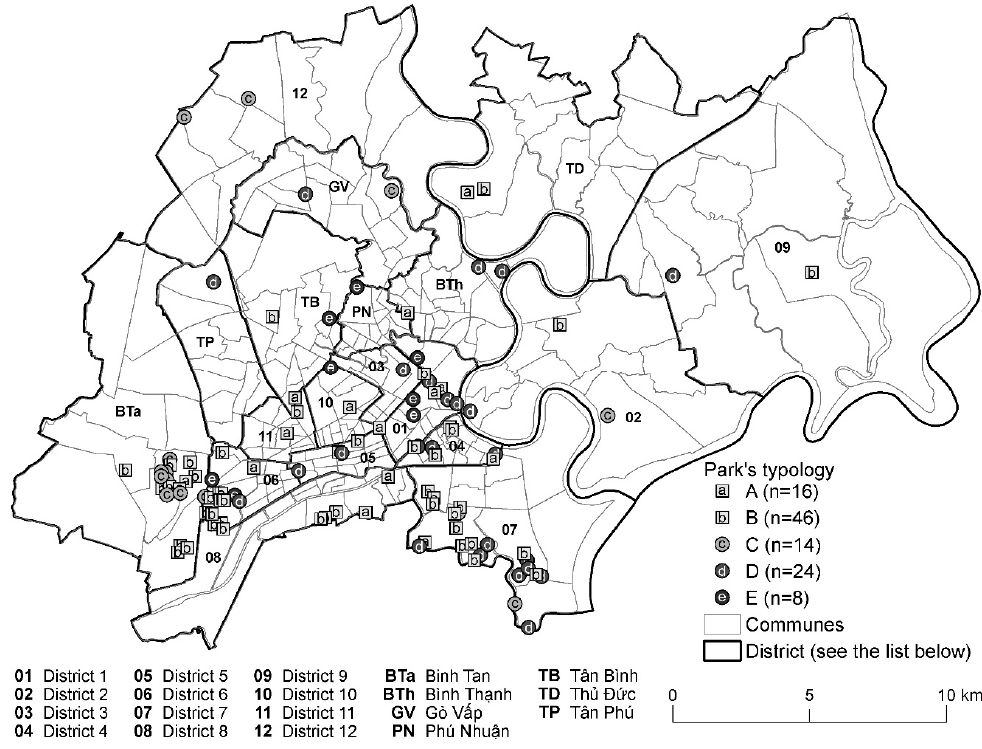
Figure 4. Spatial distribution of park types. Table 3. Spatial distribution of parks by five types a and three periods of urbanization.